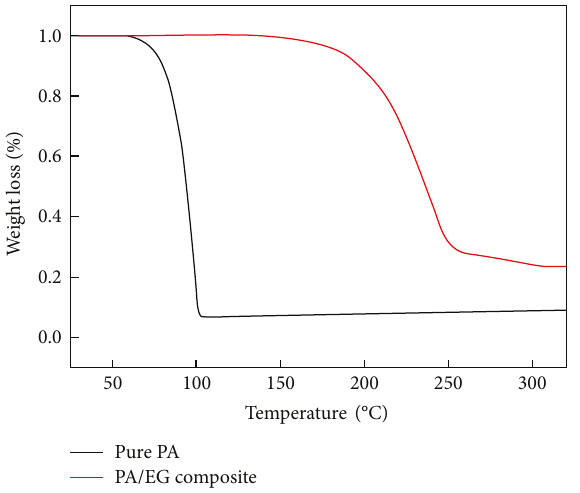
Figure 7: TG curves of pure PA and PA/EG composite PCM.